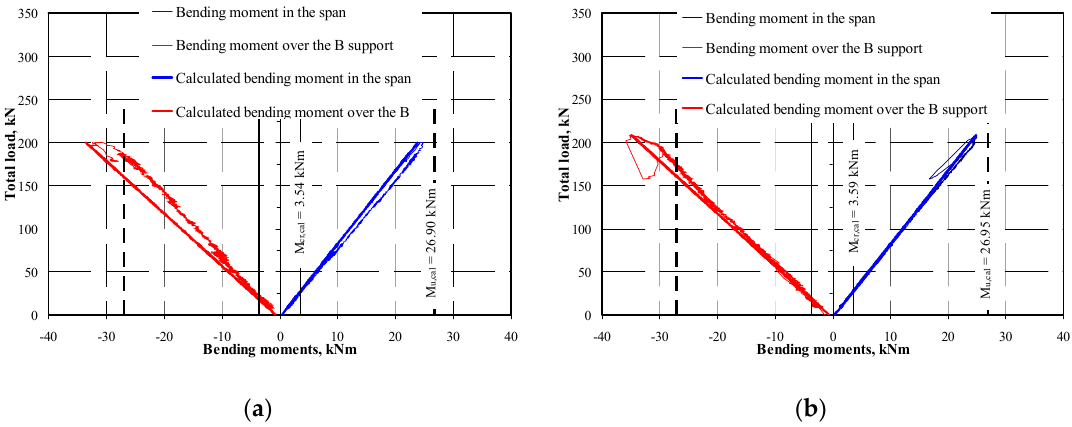
Figure 22. Changes in bending moments of: ( a ) Beam No. 1, ( b ) Beam No. 2. Table 2. Comparison of calculated and experimental results.